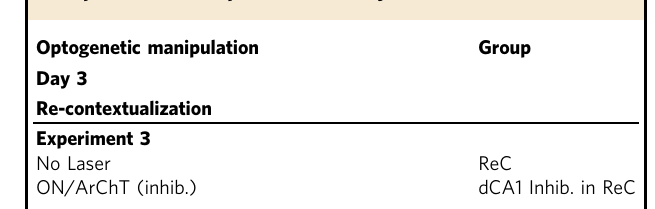
Table 3 Detailed description of the optogenetic manipulations in Experiment 3 (Day